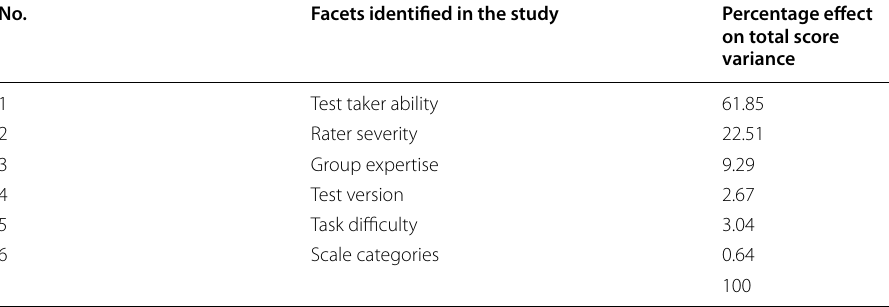
Table 7 Effect of each facet on total score variance (delayed post‑training) No. Facets identified in the study Percentage effect